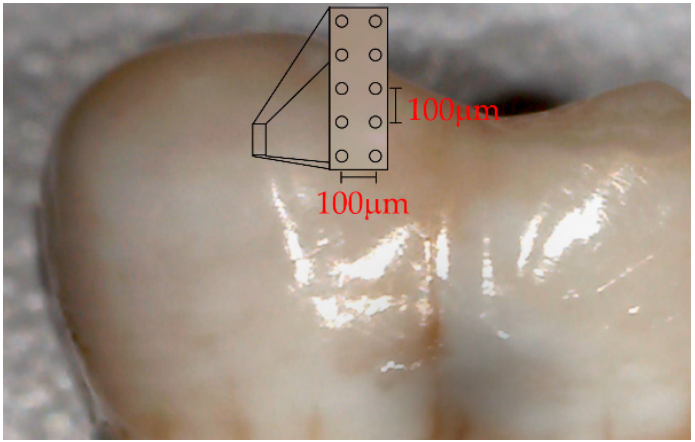
Figure 1. Photograph depicting a rectangular area used for Raman spectra acquisition under a digital microscope.